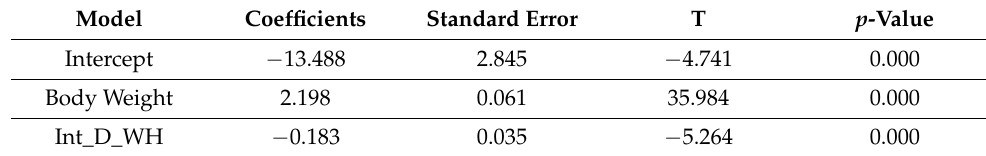
Table 9. Coefficients of stepwise backward regression for the dependent variable pelvic VI.